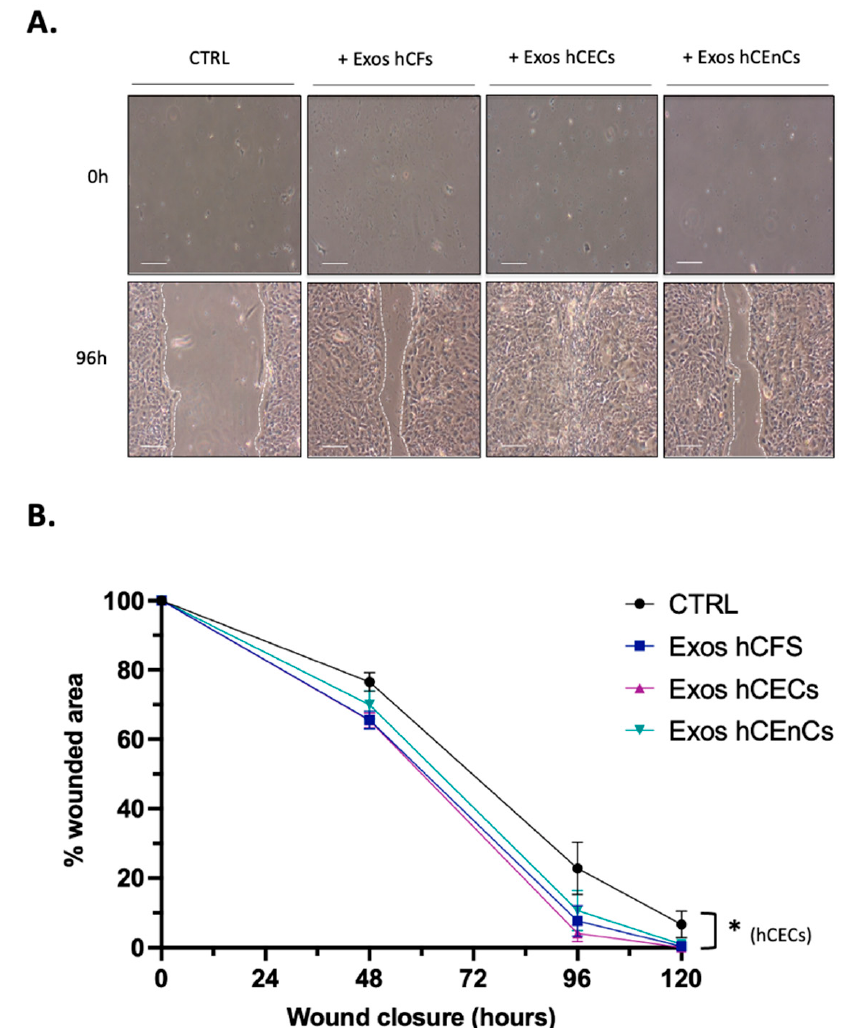
Figure 4. Impact of the three types of exosomes on wound closure of hCECs. ( A ) hCECs were grown as a monolayer and scratch-wounded. 800–1000 μ g exosomes from each corneal cell type (hCFs, hCECs and hCEnCs) were separately administrated every 48 h and hCECs were allowed to recover. Scratches were photographed 0, 48, 96 and 120 h after wounding to monitor the healing process. As a negative control, hCECs were incubated with the vehicle alone (HBS). Scale bars: 200 µ m. ( B ) The means of the wound surfaces remaining for each condition were calculated for each time interval and plotted on graph. Data is expressed as the mean ± SEM. For each time interval, results were compared to controls and the difference was considered statistically significant when * p < 0.05.